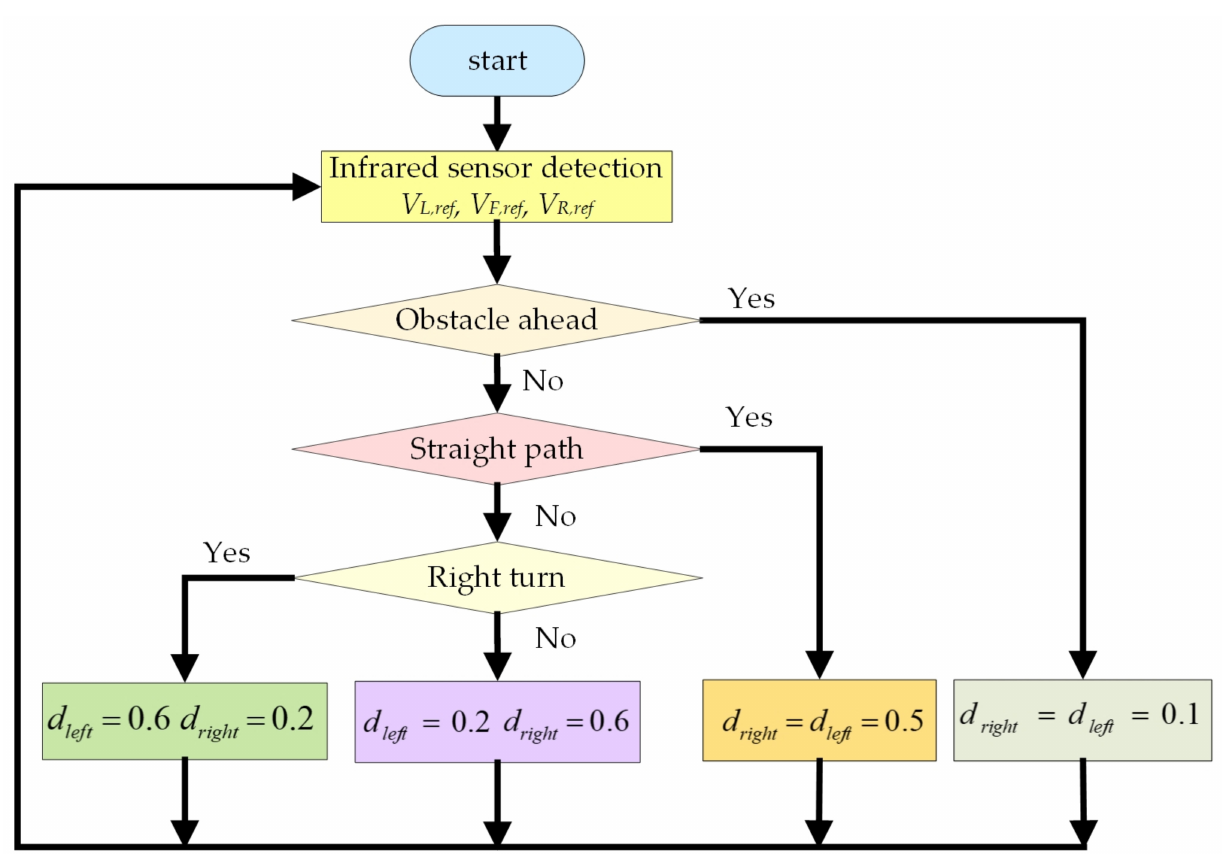
Figure 10. Flowchart of the traditional fixed duty cycle